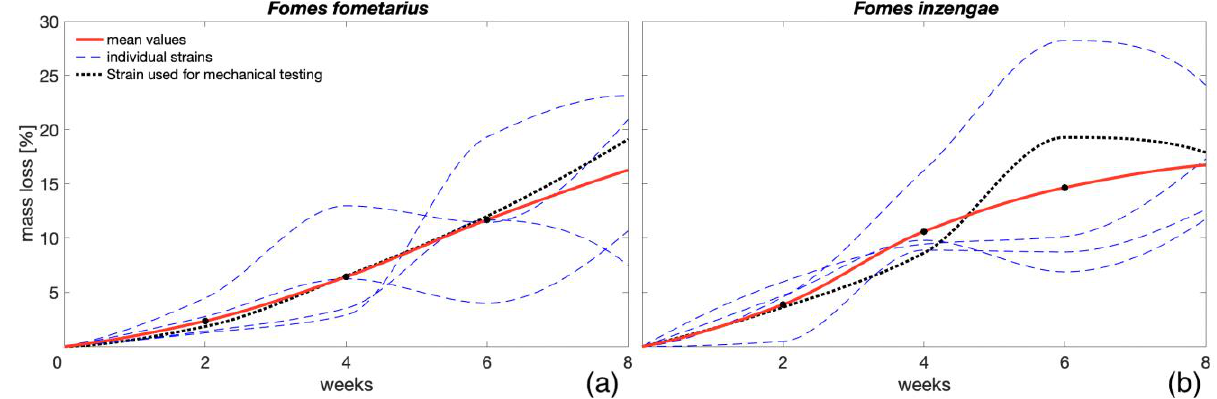
Figure 2. Average mass losses measured every two weeks of wood specimens exposed to different F. fomentarius ( a ) and F. inzengae ( b ) fungal strains.